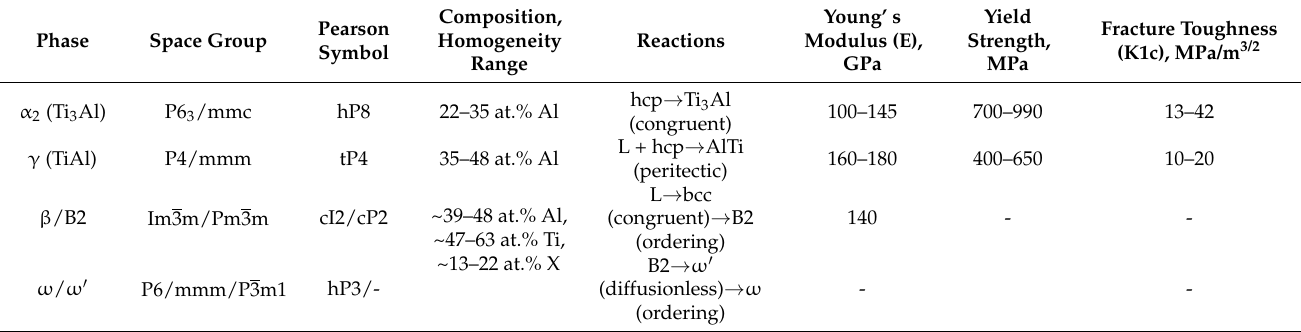
Table 2. Crystal structure, formation routs, and selected properties of phases in Ti-Al-based alloys [17,26–28]. Phase Space